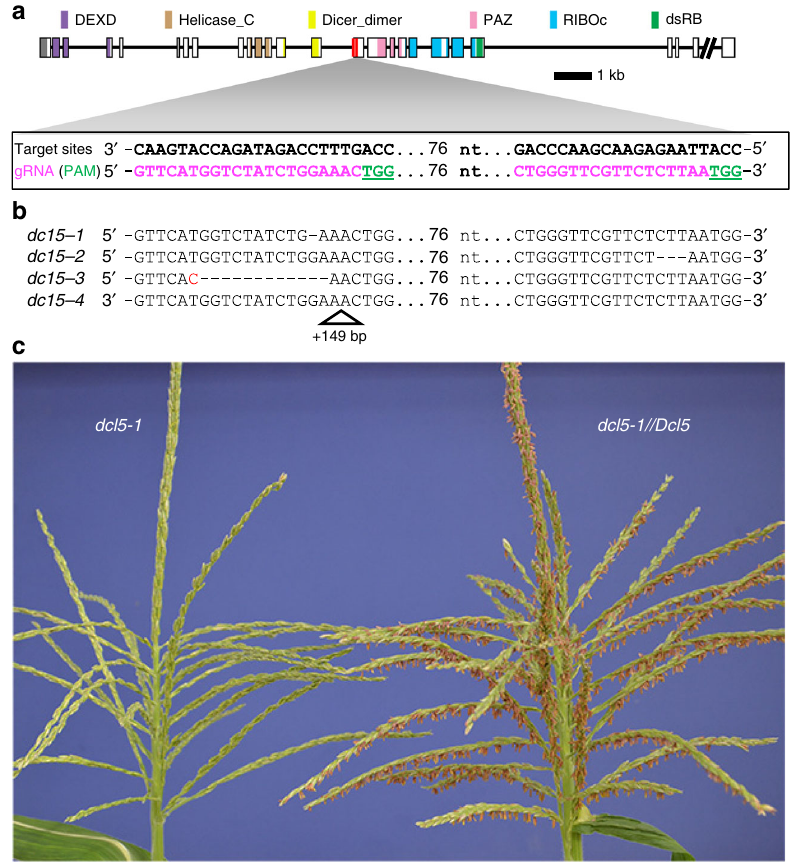
Fig. 1 CRISPR-Cas9 was used in maize to mutate Dcl5 . a Schematic diagram of the Dcl5 gene model. Conserved domains were identi fi ed using the NCBI conserved domain search tool against database CDD v3.16. All domains were found with extremely high con fi dence except the double stranded RNA- binding (dsRB) domain, which had an e -value of 0.05. b Sequences of the four CRISPR-Cas9-generated mutant alleles selected for this study. c A dcl5-1 tassel lacking any exerted anthers (left) and a sibling heterozygous dcl5-1//Dcl5 plant at peak pollen shed with hundreds of exerted anthers